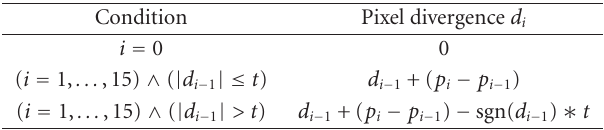
Table 1: Definition of pixel divergence, where the divergence is con- sidered as noise if it is below a certain